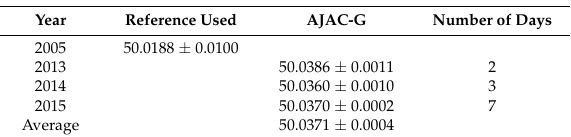
Table 1. Height differences between permanent Global Positioning System (GPS) (AJAC) and tide gauge (G) at Ajaccio (in